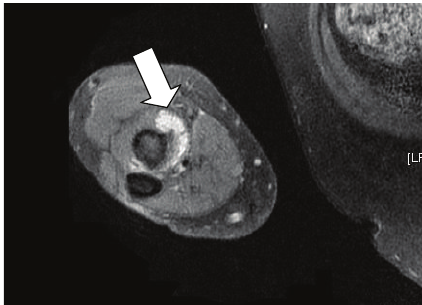
Figure 3: MRI axial T2 weighted image after IV gadolinium clearly highlighting the bursa structure (thick arrow).